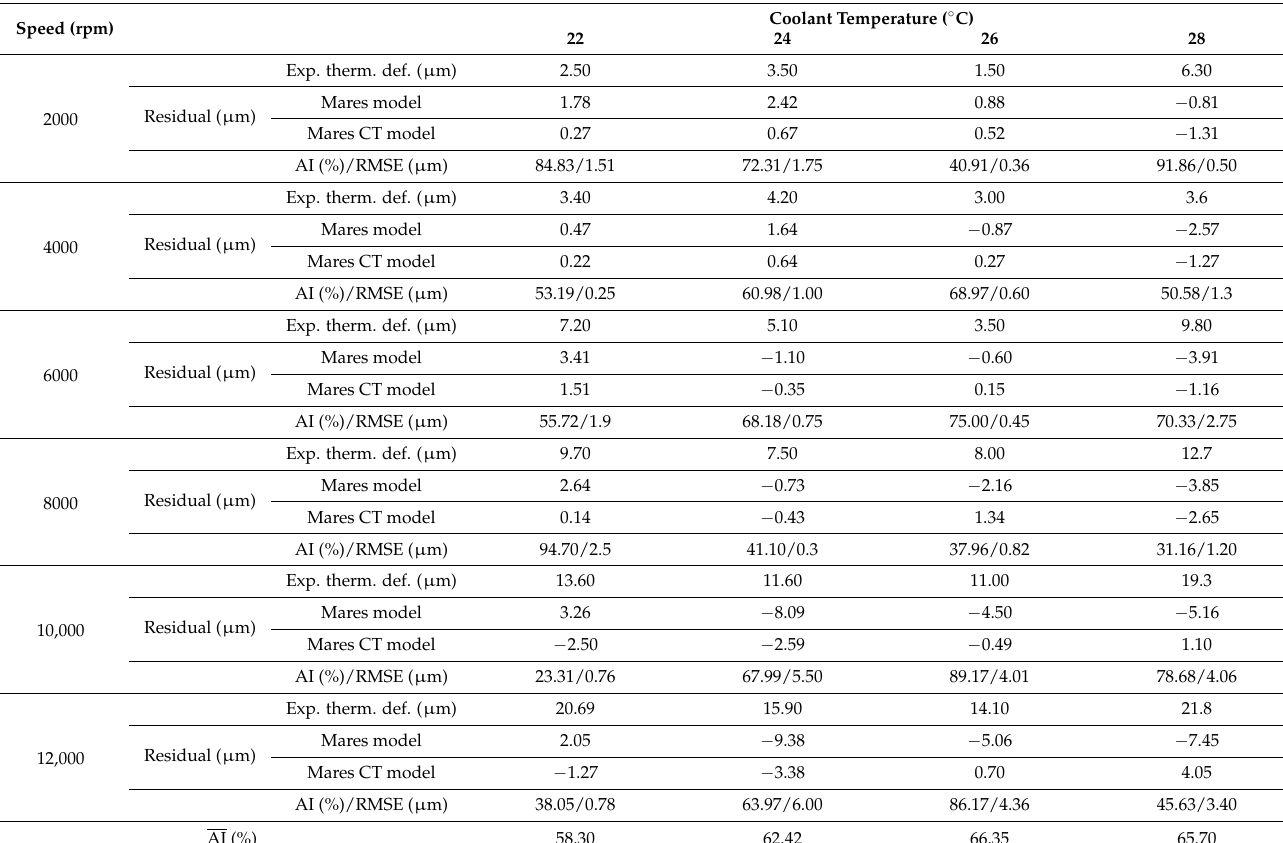
Table 4. Residual thermal errors, AI, RMSE, and AI between the Mares and Mares CT models with regard to experimental thermal deformation (exp. therm. def.) at different coolant temperatures and spindle rotating speeds at a constant flow rate of 5 LPM and a 26 ◦ C ambient temperature with a CNC machine with a direct-drive